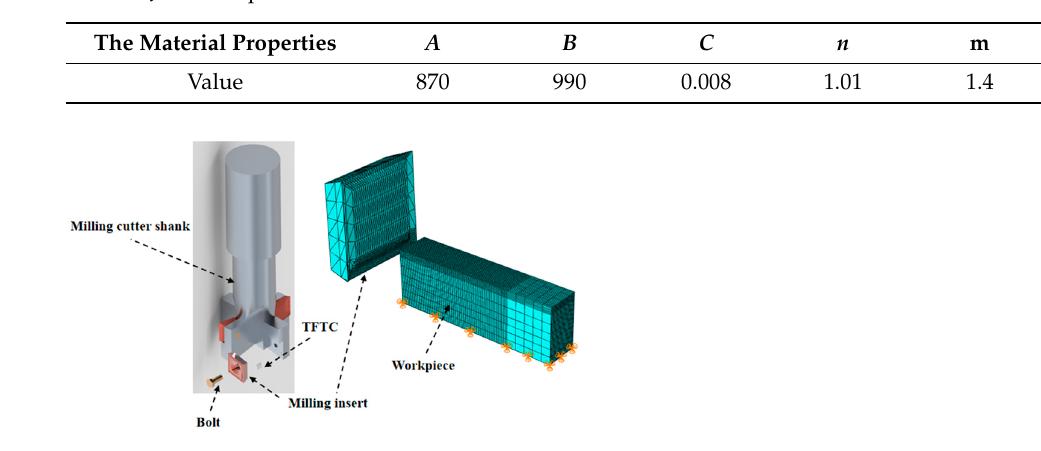
Figure 1. Simulation model and meshing of titanium alloy